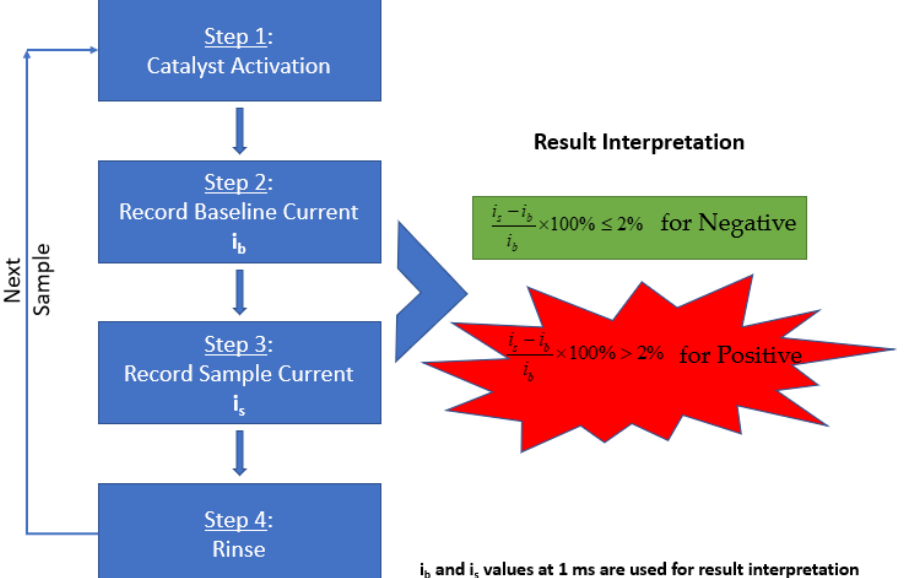
Figure 7. Schematic of the steps involved in diagnosing the aqueous sample solution using UFC-19. The baseline and sample currents recorded are processed through the mentioned equation to determine the result of the collected sample.